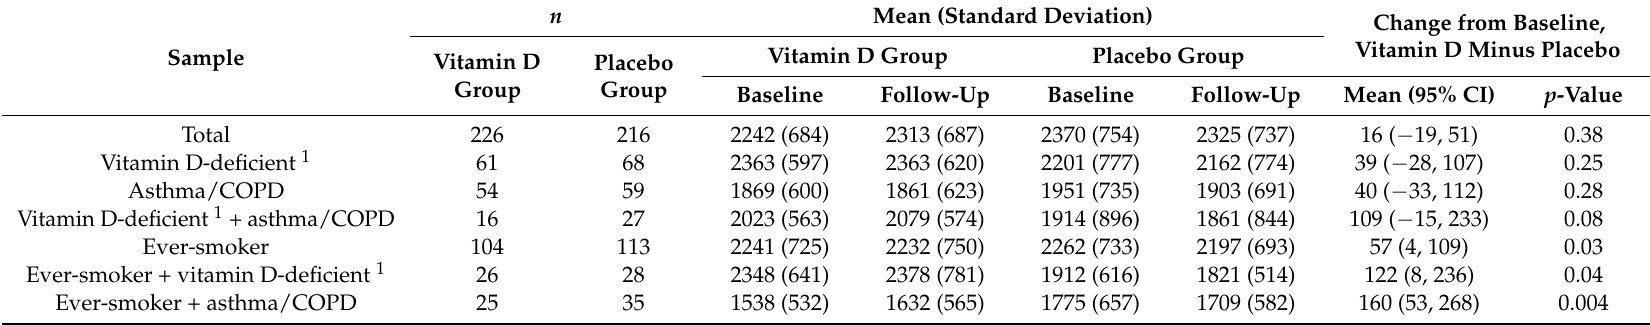
Table 2. Forced expiratory volume in 1 s (mL) at baseline and follow-up (adjusted for age, sex, ethnicity and height) by treatment group.